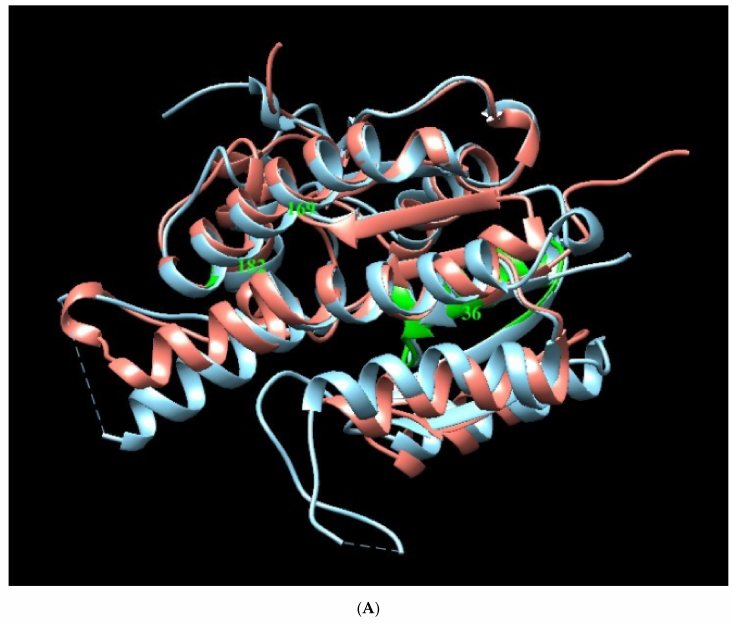
Figure A3. Complex of PTR1 (PDB ID: 1E7W) with three physiological ligands : NADP (magenta), MTX (yellow) and THB (white) . Small box, total vision, and big box, augmented vision of the protein surface in transparency style of USCF Chimera program.